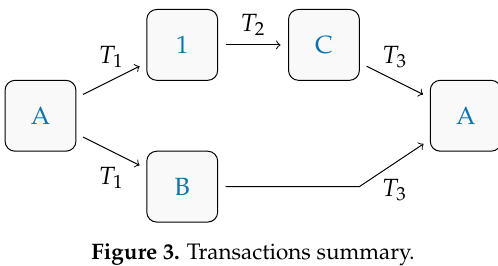
Figure 3. Transactions